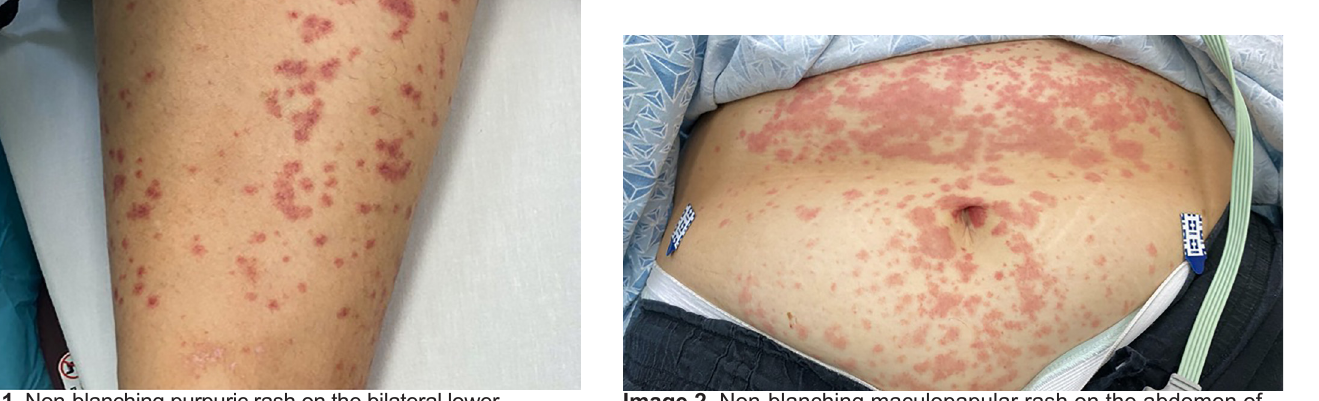
Image 2. Non-blanching maculopapular rash on the abdomen of a patient with COVID-19 with concurrent non-blanching purpuric rash on the bilateral lower